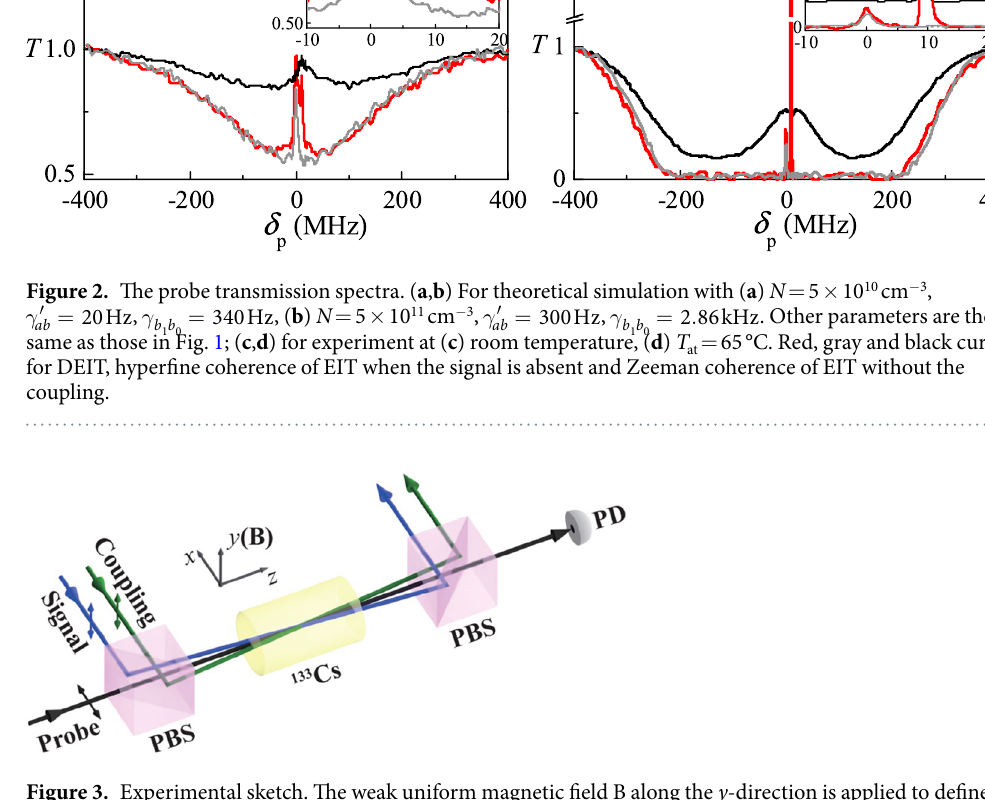
Figure 3. Experimental sketch. The weak uniform magnetic field B along the y -direction is applied to define the quantization axis. PBS: polarizing beam splitter, PD: photodetector. ↕ denotes the linear